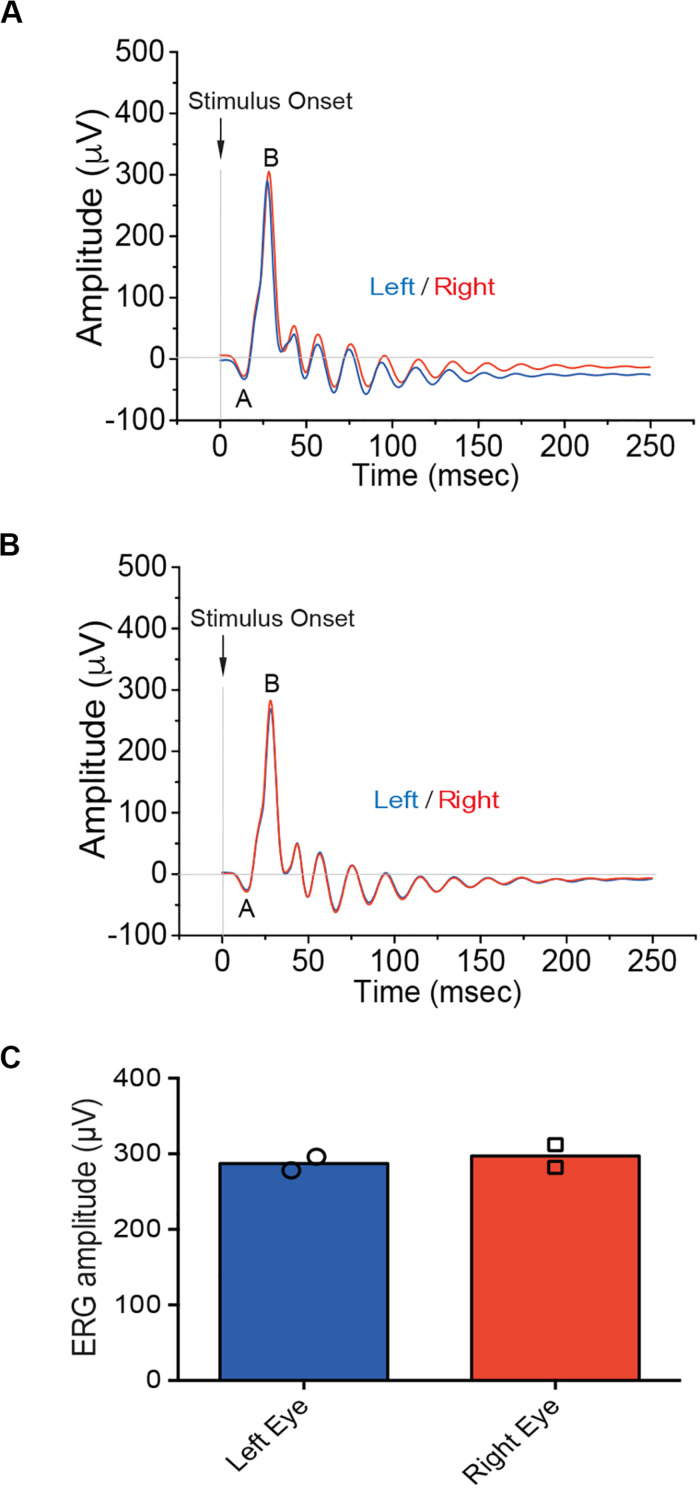
Electroretinographic responses in naïve pigs. (A,B) Representative ff-ERG recordings in the left (blue trace) and right (red trace) eyes, respectively, from the G1 (A) and G2 (B) naïve pigs (n = 2). (C) Bar plots (means with superimposed experimental points) depicting the amplitude of the ff-ERGs b-wave (μV) in the left and right eyes of the G1 and G2 pigs. The electrophysiological recordings of ff-ERGs show that b-wave amplitudes are not different in both naïve pigs validating the experimental approach used to assess retinal functionality.